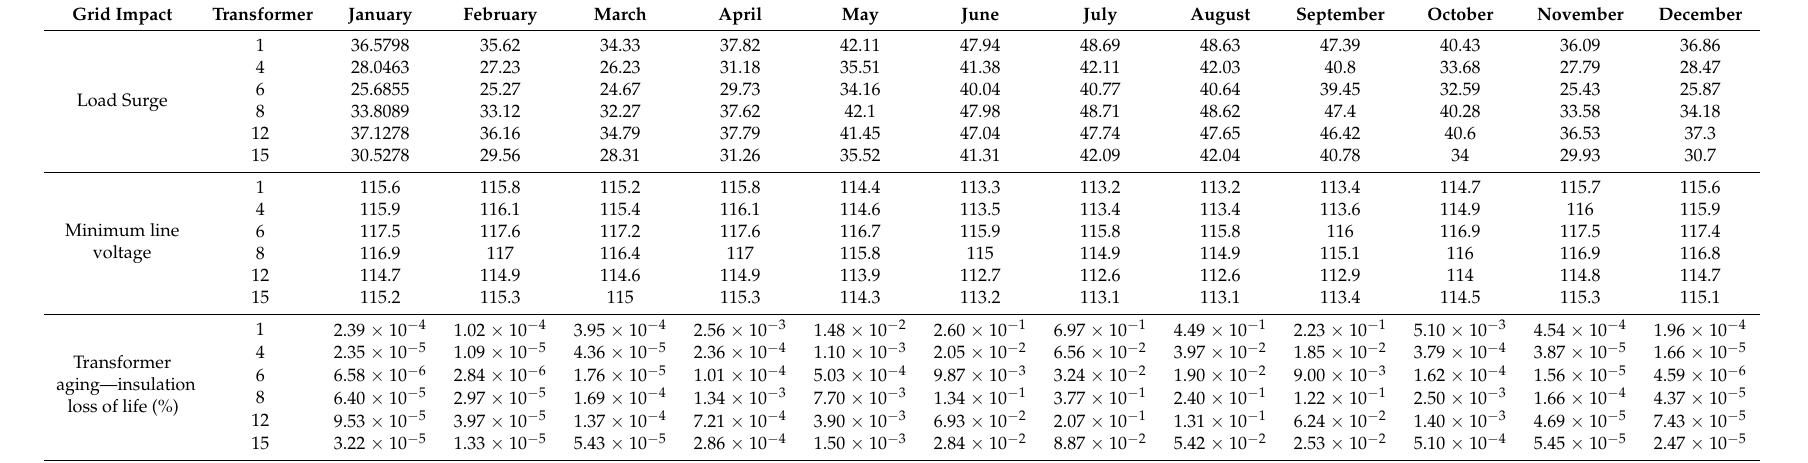
Table A2. Summary of the impact of uncontrolled PEV charging in 12